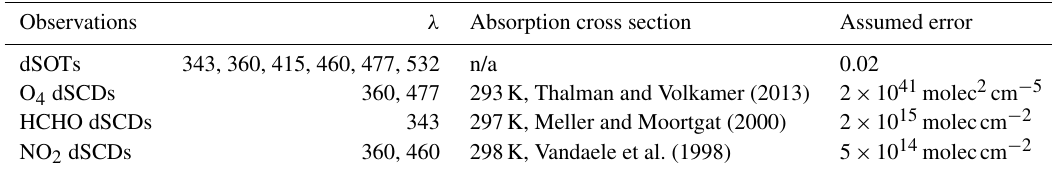
Table 1. Overview of the simulated observations. Wavelengths are in nanometres. Observations λ Absorption cross section Assumed error dSOTs 343, 360, 415, 460, 477, 532 n/a O 4 dSCDs 360, 460 298K, Vandaele et al. (1998) n/a: not applicable.